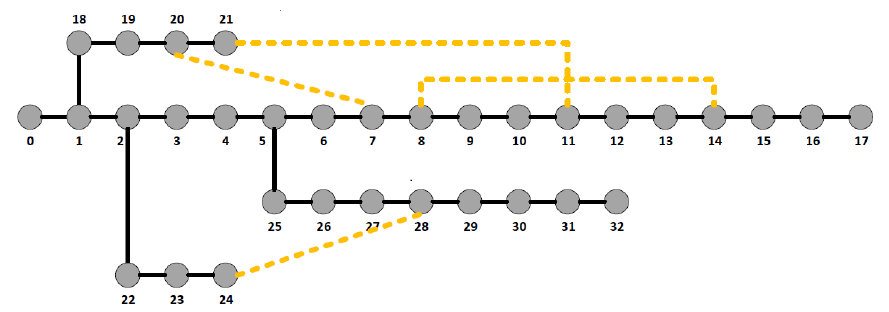
Figure 3. IEEE 33-node distribution network.